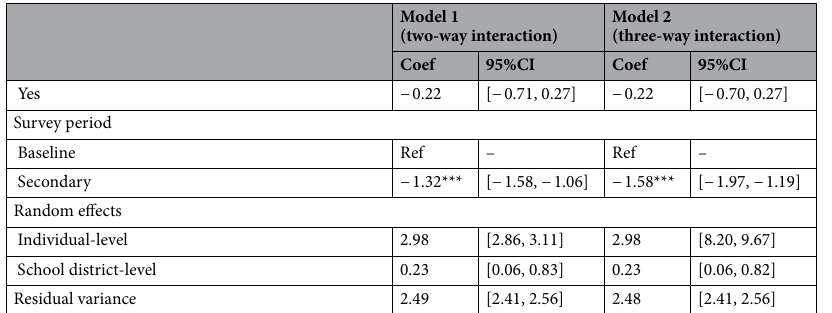
Table 2. Multilevel regression adjusted coefficient and 95% confidence interval of individual attributes and coastal exposure (sea visibility and coastal proximity) from multiple imputation analysis for changes in mental